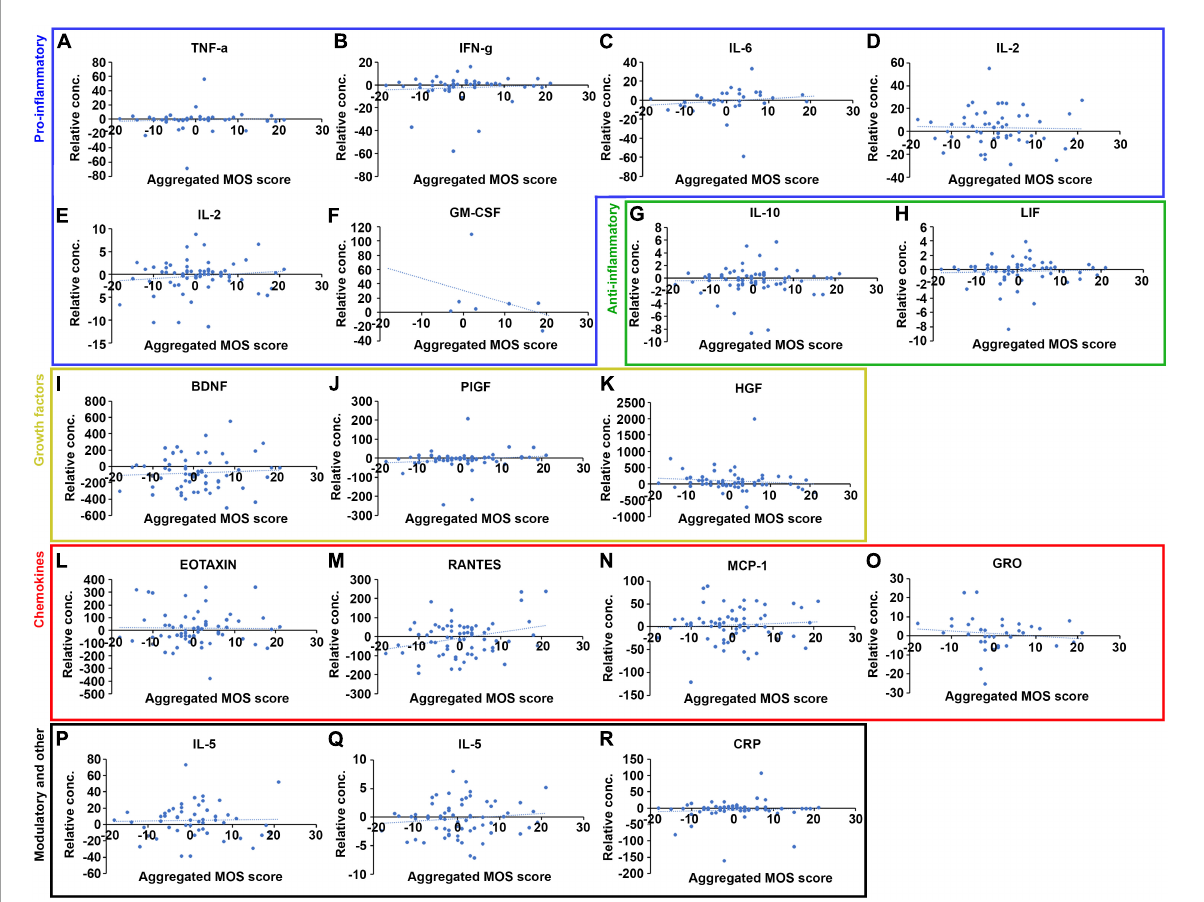
FIGURE5 Correlation between changes in cytokine biomarker plasma levels and changes in sleep quality between baseline and follow-up for a few of the 17 selected cytokines. Changes in plasma levels plotted against changes in aggregated MOS score, calculated as the plasma level or MOS score at follow-up minus the plasma level/MOS score at baseline, for each of the 17 selected cytokines and organized into functional groups including pro-inflammatory ( A–F , blue box), anti-inflammatory ( G–H , green box), growth factors ( I–K , yellow box), chemokines ( L–O , red box) and immune-modulatory and other ( P–R , black box) biomarkers. N = 71, blue dashed lines indicate linear regression curves for the sample